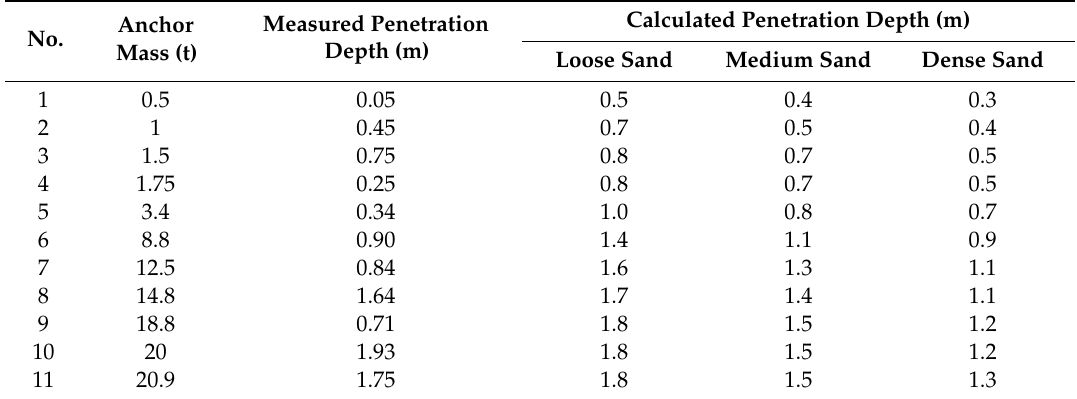
Table 6. Penetration depth of the anchor in sand soil substrate.